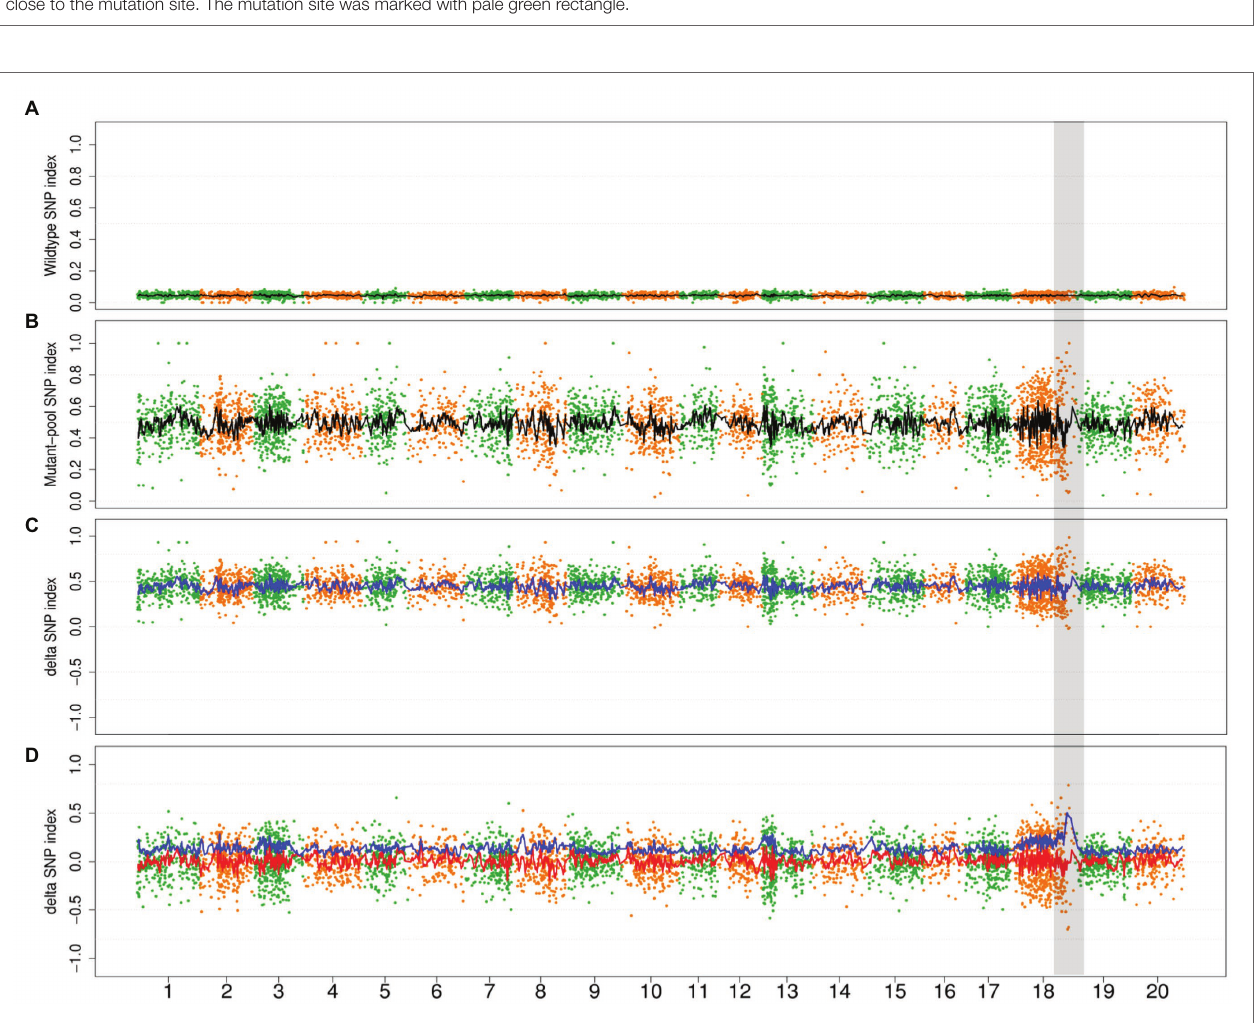
FIGURE 6 | The simulation result of 90% progenies in wild-type bulk of population Mut03 from noncausal mutagenic cells. (A,B) The distribution of SNP index in wild type and mutant bulks in whole-genome level. Each point represents a SNV, and the black line is the fitted curve of SNP index, the candidate region is highlighted with gray color. (C) The distribution of DSI and ADSI. Each point represents a SNV, the red line is the fitted curve of DSI, and the blue line is the fitted curve of ADSI, while two curves overlap completely in this plot. (D) The distribution of adjusted DSI (zero-centering) and ADSI. Each point represents a SNV, the red line is the fitted curve of DSI, and the blue line is the fitted curve of